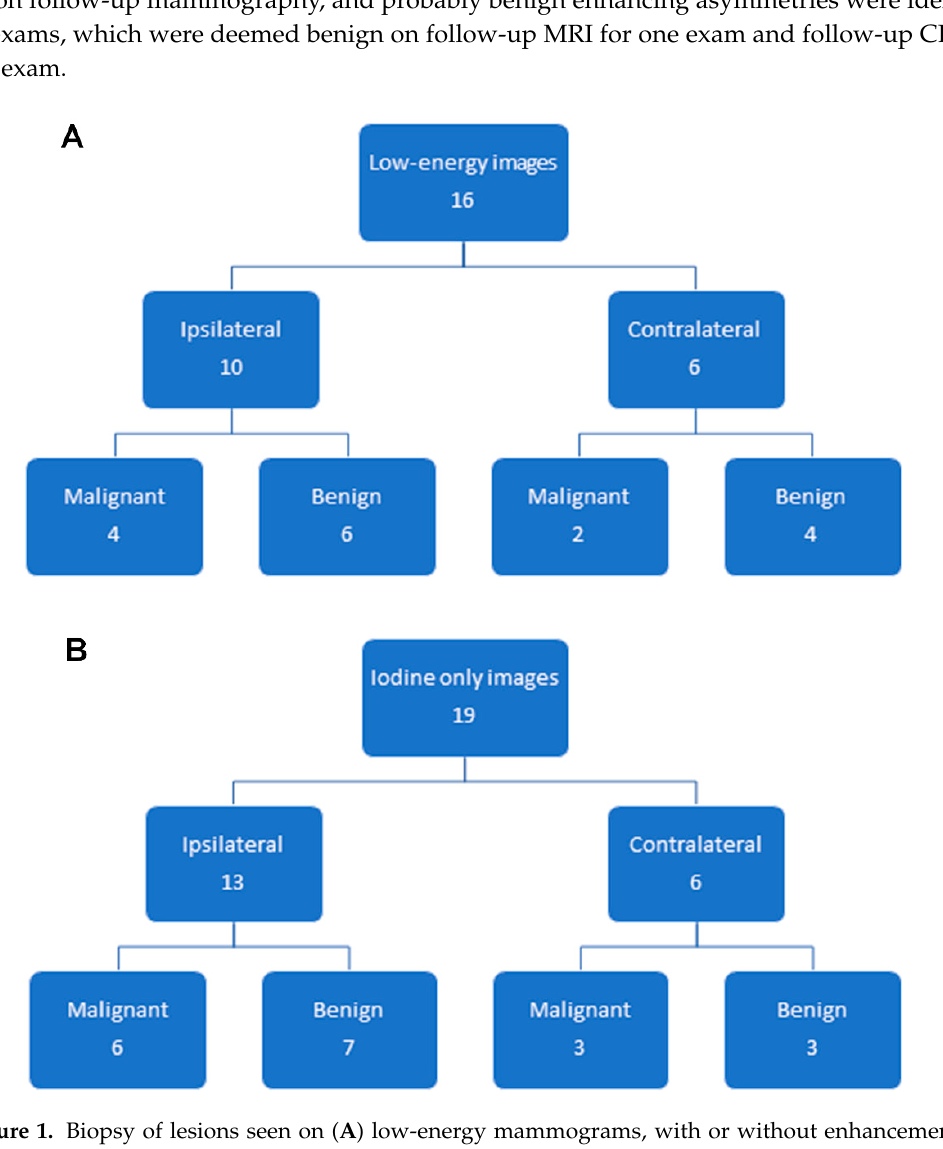
Figure 1. Biopsy of lesions seen on ( A ) low-energy mammograms, with or without enhancement, and ( B ) lesions seen only on iodine images. Interval cancers are not included. Ipsilateral = ipsilateral to the lumpectomy bed and contralateral = contralateral to the lumpectomy bed.